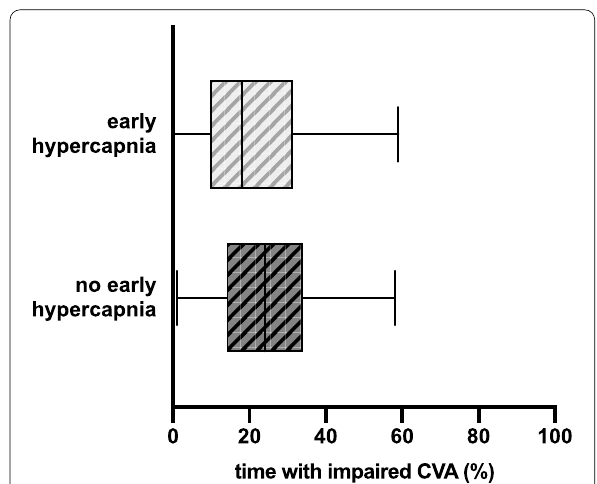
Fig. 2 Early hypercapnia and cerebrovascular autoregulation. Shows the time with impaired cerebrovascular autoregulation (CVA; in % of the total monitoring time) in ARDS patients with early hypercapnia vs. no early hypercapnia. The COx was depicted as a moving linear correlation based on mean arterial pressure and cerebral oxygenation (ICM , Cambridge Enterprise, Cambridge, UK). Impaired + cerebrovascular autoregulation was defined as a COx > 0.3. ARDS Acute respiratory distress syndrome, COx cerebral oxygenation index. Data are presented as median (boxes) with Tukey